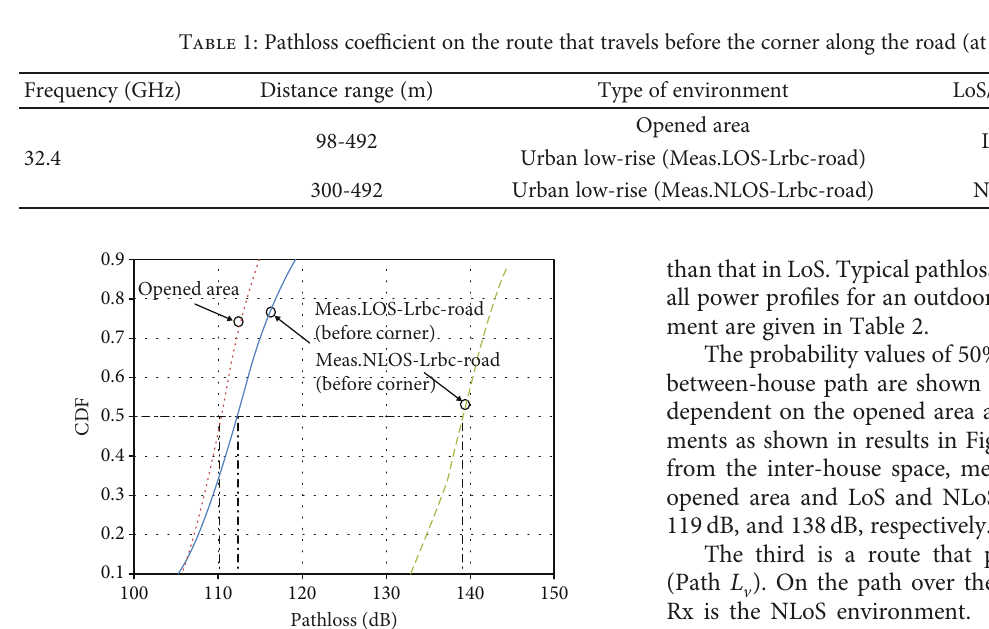
Figure 8: CDF on the route that travels before the corner along the road (at site-speci fi c).